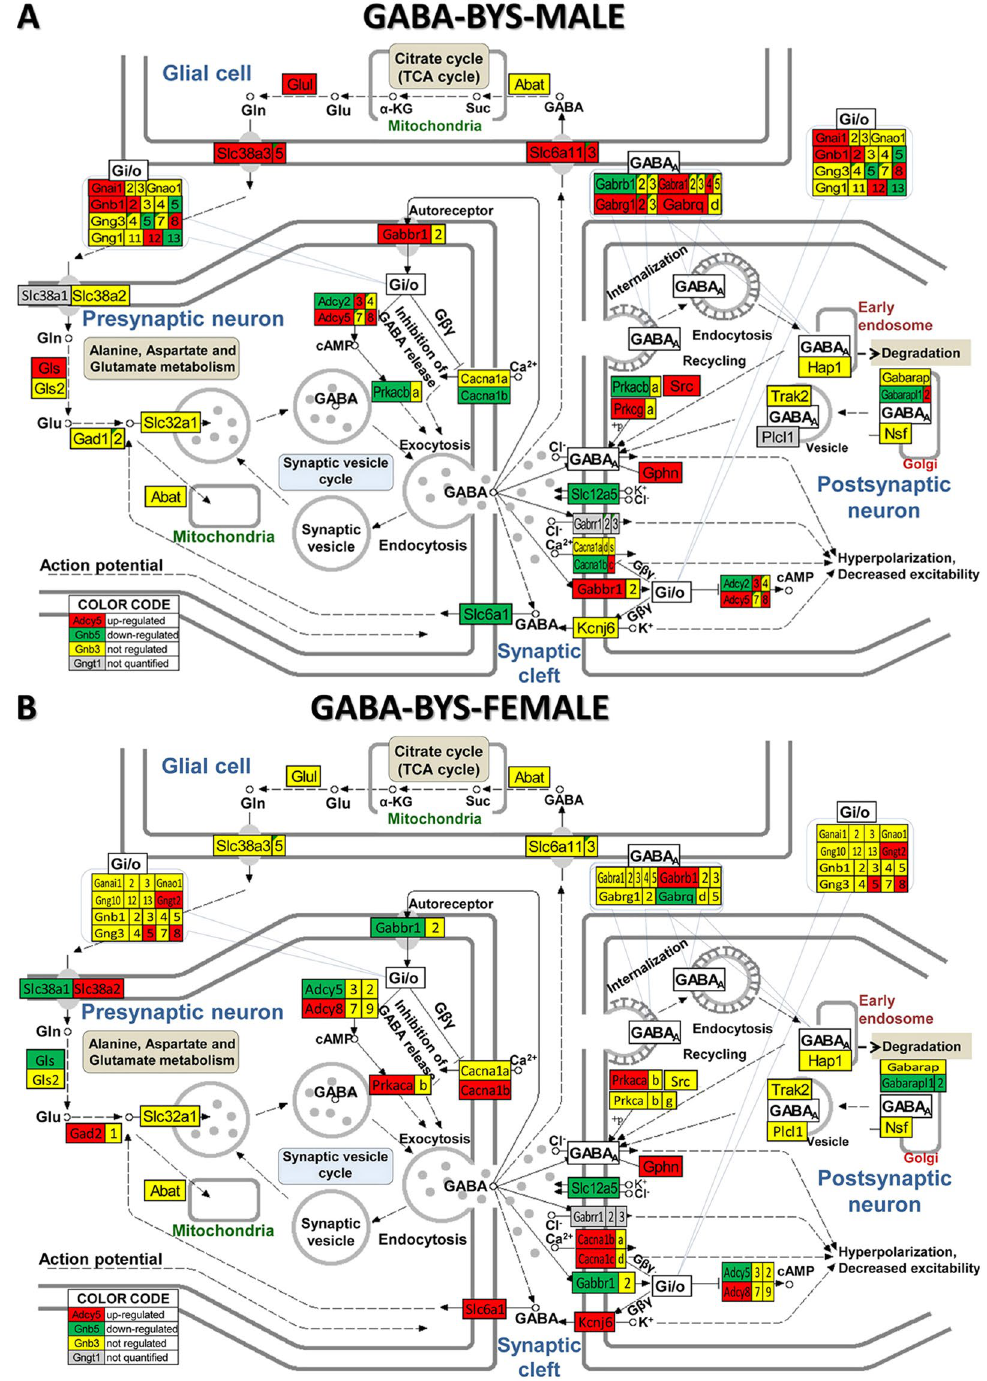
Figure 3. KEGG (www.kegg.jp/kegg/kegg1.html) map of regulation of the GABAergic synapse pathway in the arcuate nucleus of saline-treated betamethasone–primed male ( A ) and female ( B ) rats with NMDA- induced infantile spasms (BYS) compared to counterparts without spasms (BNS). Inset tables indicate how the composing genes of the labelled Gi/o (G-proteins) block are regulated in that condition. Gene symbol background indicates whether expression of a gene was upregulated (red), downregulated (green), unaltered (yellow) or not quantified